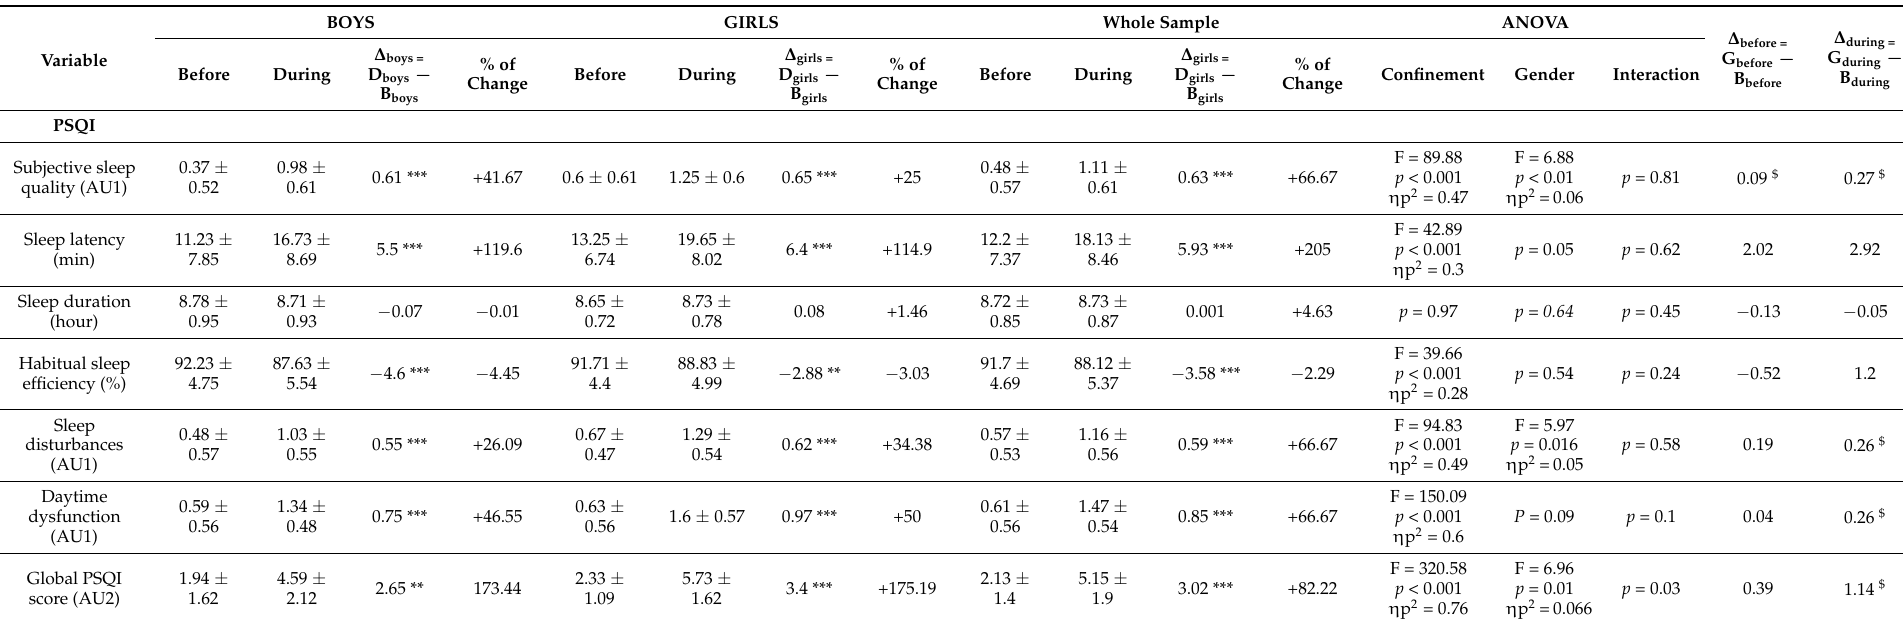
Table 2. Reponses to the PSQI recorded before and during home